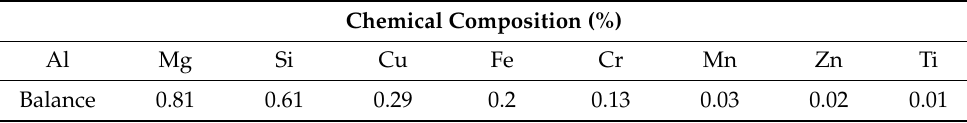
Table 1. Chemical composition of AA6061-T6 alloy.